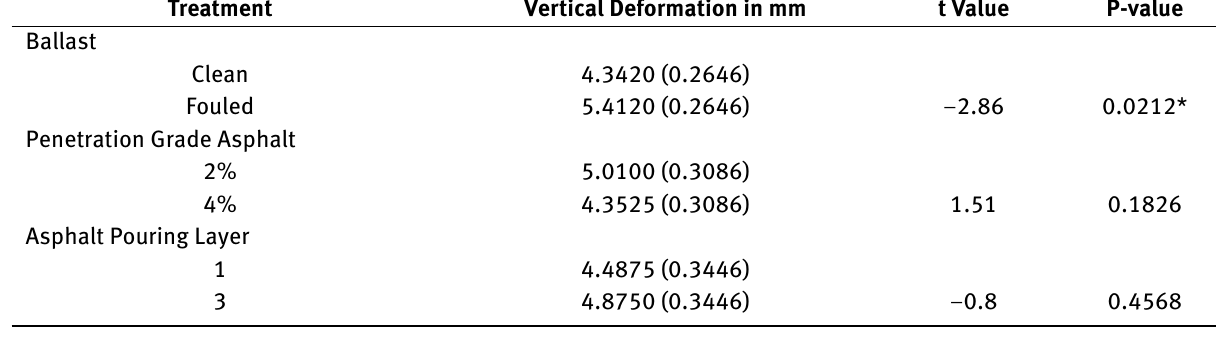
Table 5: Compared means of vertical deformation